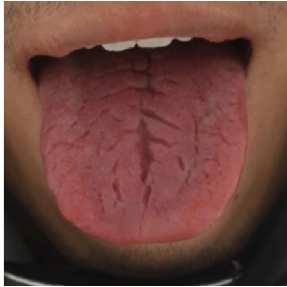
Figure 1. Typical image of cracked